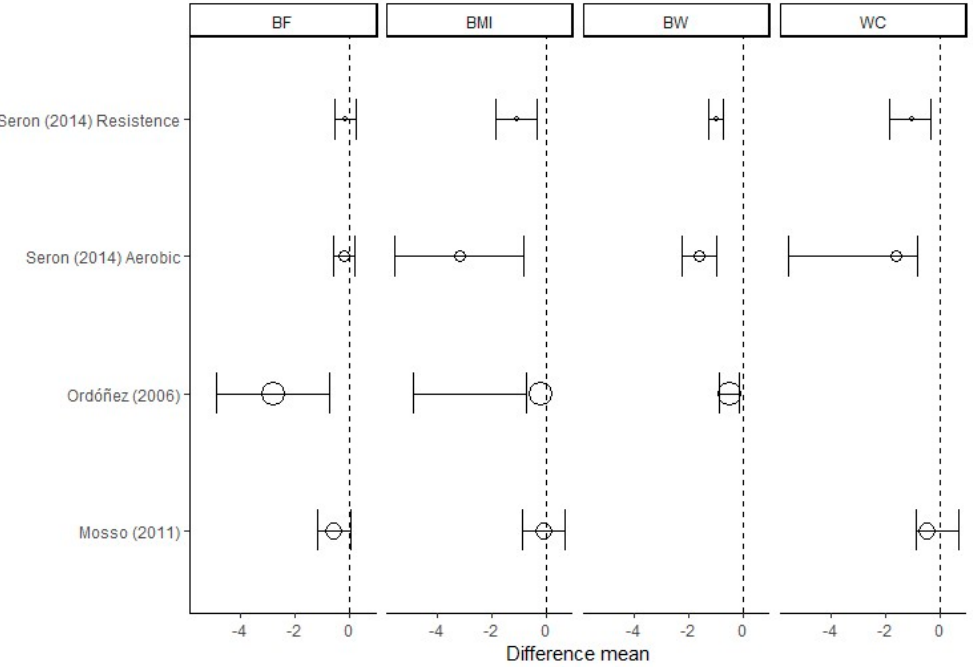
ff erences (with 95% confidence interval) in children and adolescents Figure 2. Within ‐ group differences (with 95% confidence interval) in children and adolescents trials. Figure 2. Within-group di